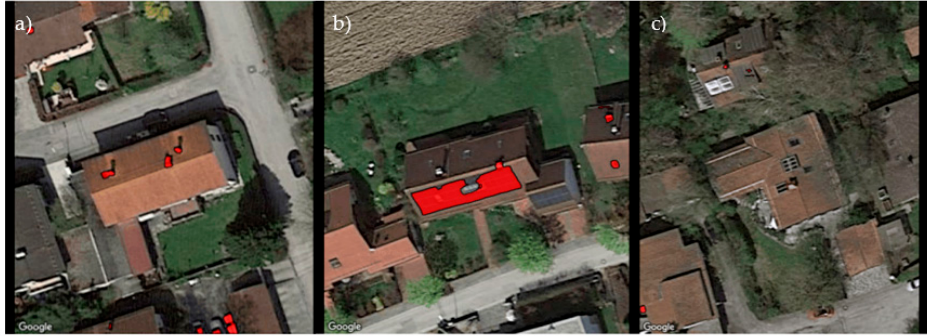
Figure 6. Example results of the superstructure segmentation, ( a ) led to a correct segmentation, ( b ) shows mediocre segmentation, and ( c ) led to incorrect segmentation.